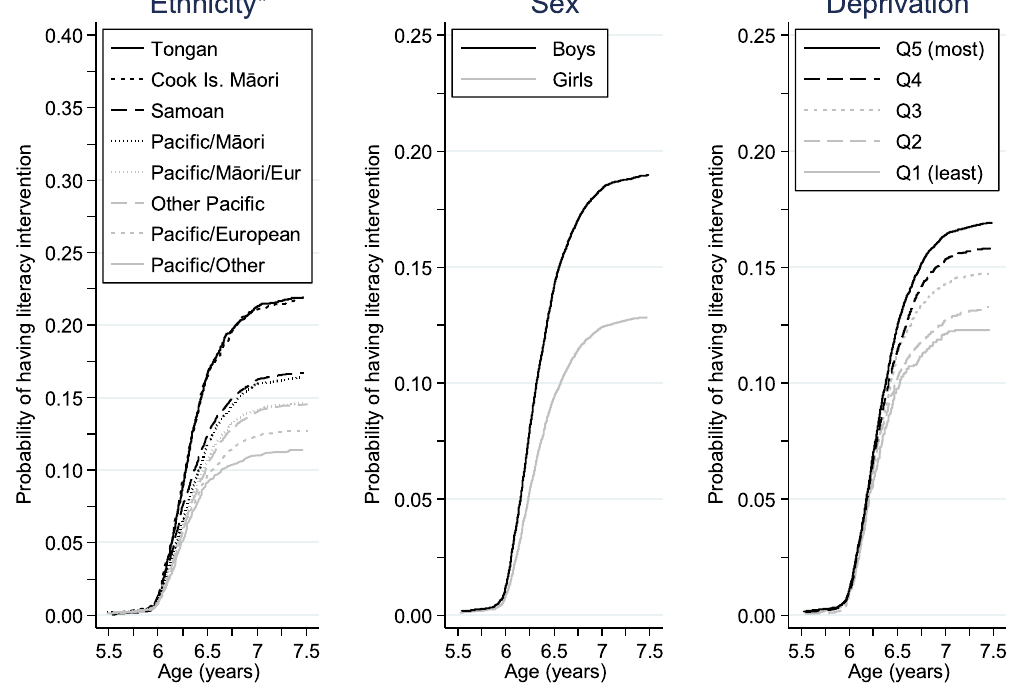
Figure 1. Kaplan-Meier curves of probability of having a literacy intervention by ethnicity, sex and deprivation, measured using quintiles of the NZDep2013 score (note: * the vertical axis for ethnicity is different from that used for sex and